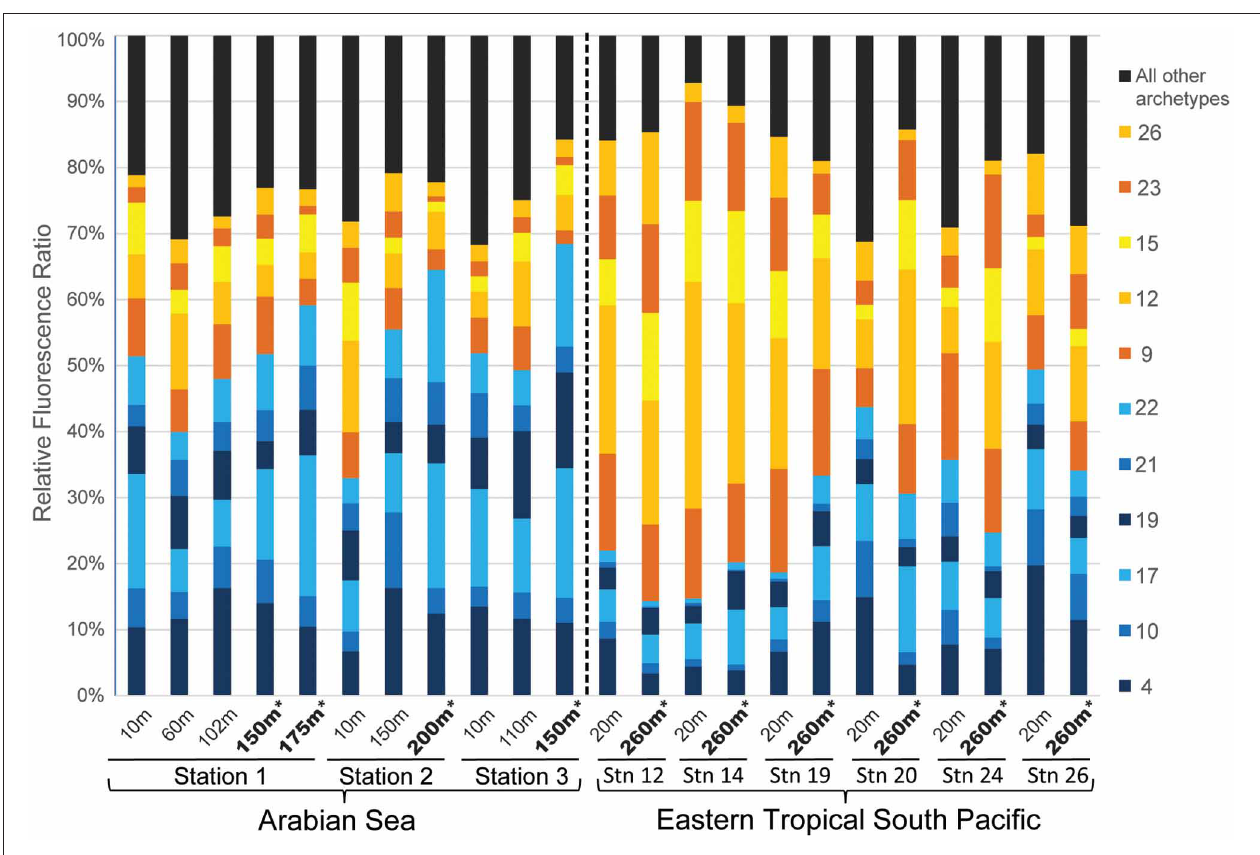
FIGURE 4 | Relative fluorescence ratios (RFR) of archaeal amoA archetypes from samples collected in the Arabian Sea and the ETSP. Numbers in the legend represent the AOA archetype identification number. The AOA archetypes that were important constituents of the Arabian Sea